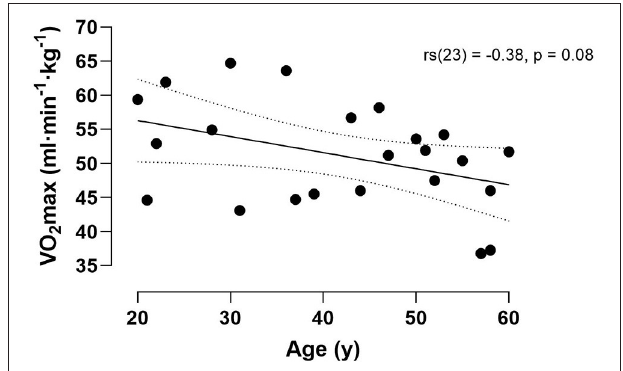
FIGURE 1 | Correlation between VO 2 max and age. Dotted lines denote 95% CI.